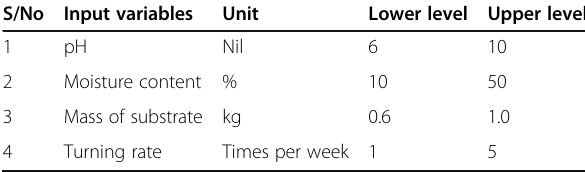
Table 3 Ranges and levels of selected input